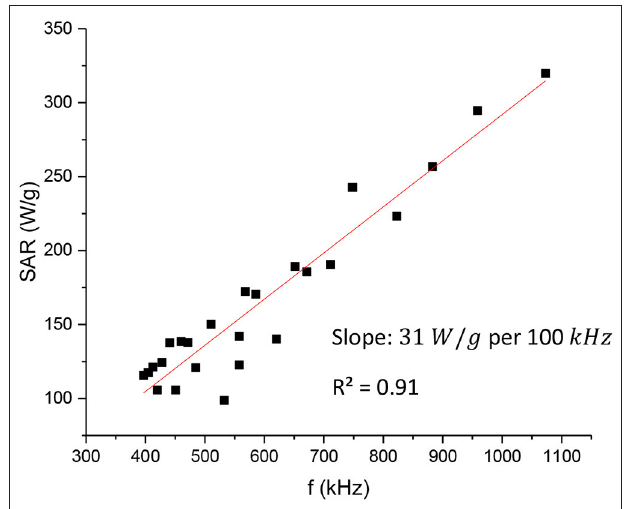
FIGURE 8 | Hyperthermia heat produced per unit te vs. the excitation